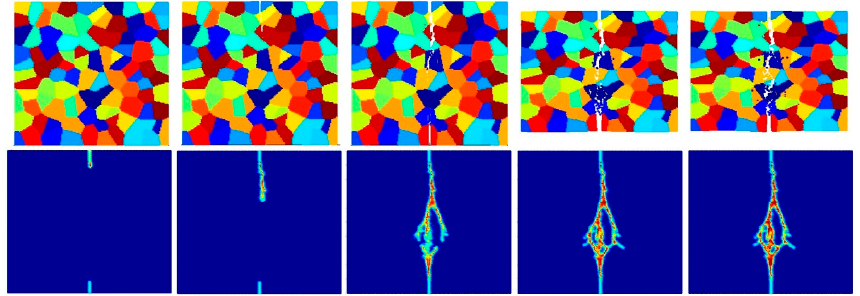
Figure 30. Fracture pattern of polycrystal when β = 2.0 with 100 grains in total. From left to right: time = 1.5 µ s, 2.0 µ s, 2.5 µ s, 3.0 µ s, and 3.5 µ s, respectively.